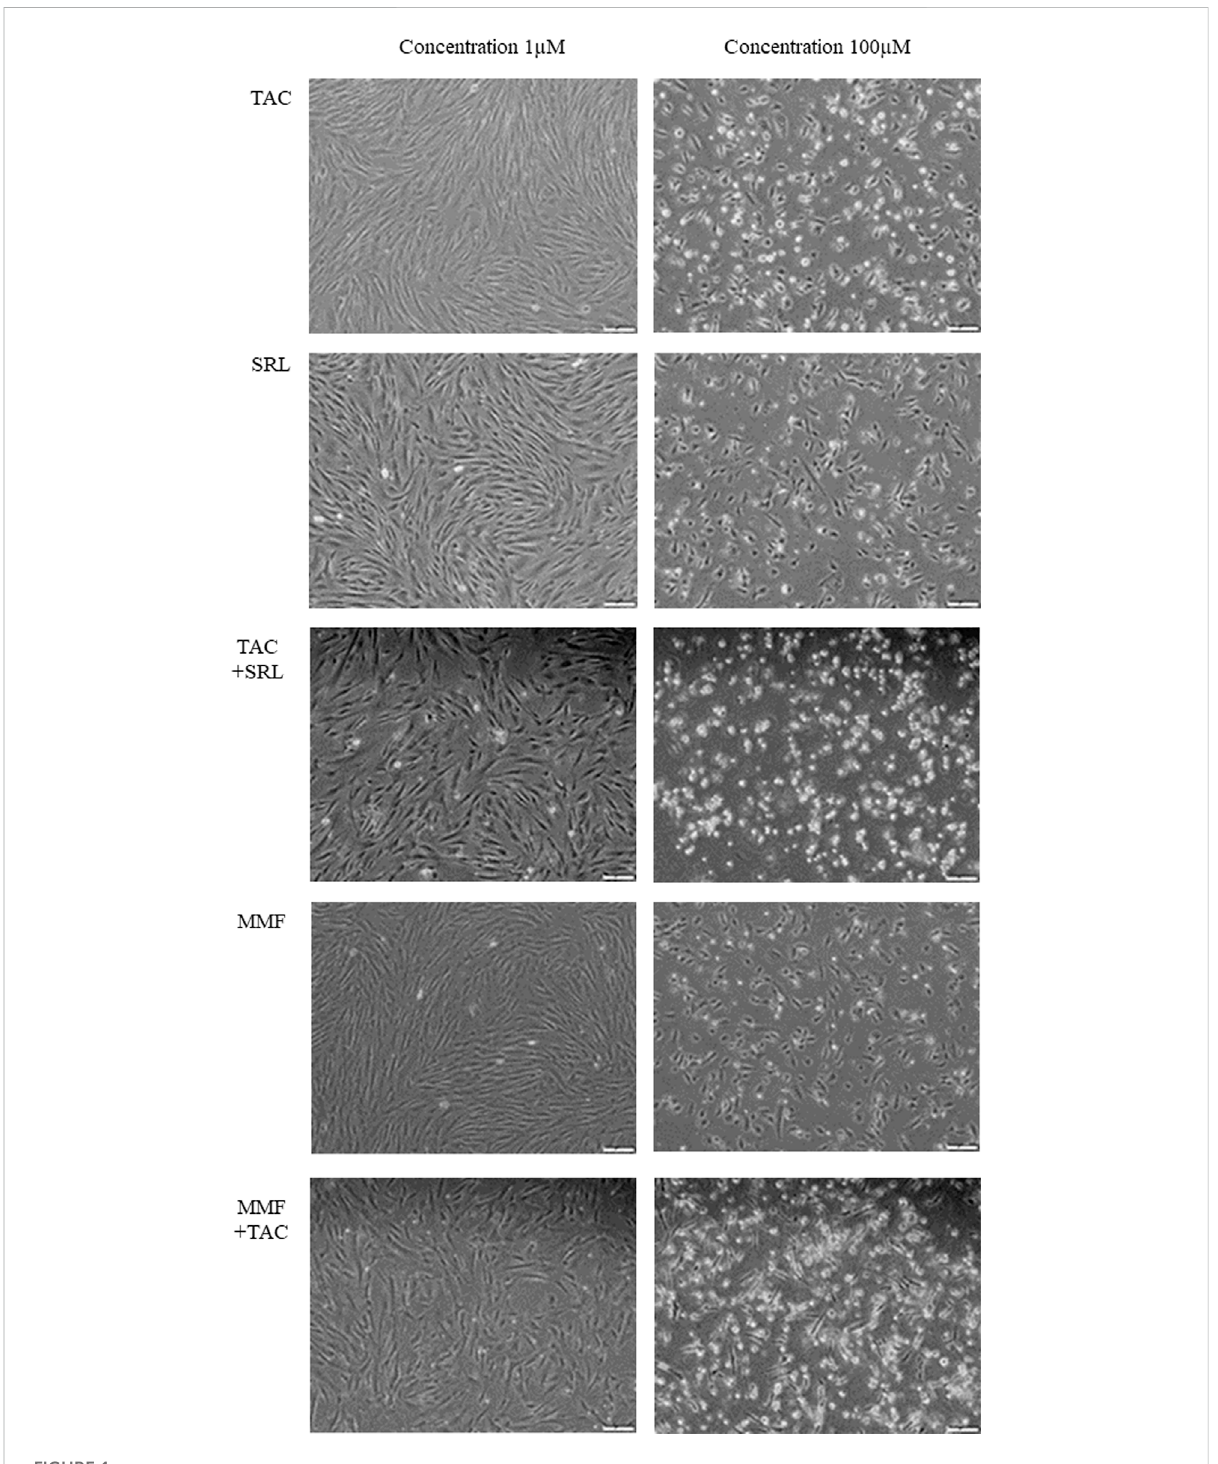
FIGURE 1 Examination of the hepatocyte cultures isolated from human cirrhotic liver after treatment with immunosuppression medication at a concentration of 1 µM and respectively 100 µM (Inverted microscope, phase contrast, 40X).